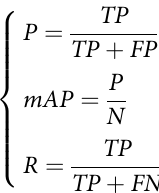
Table 1. Experimental results of different detection methods.